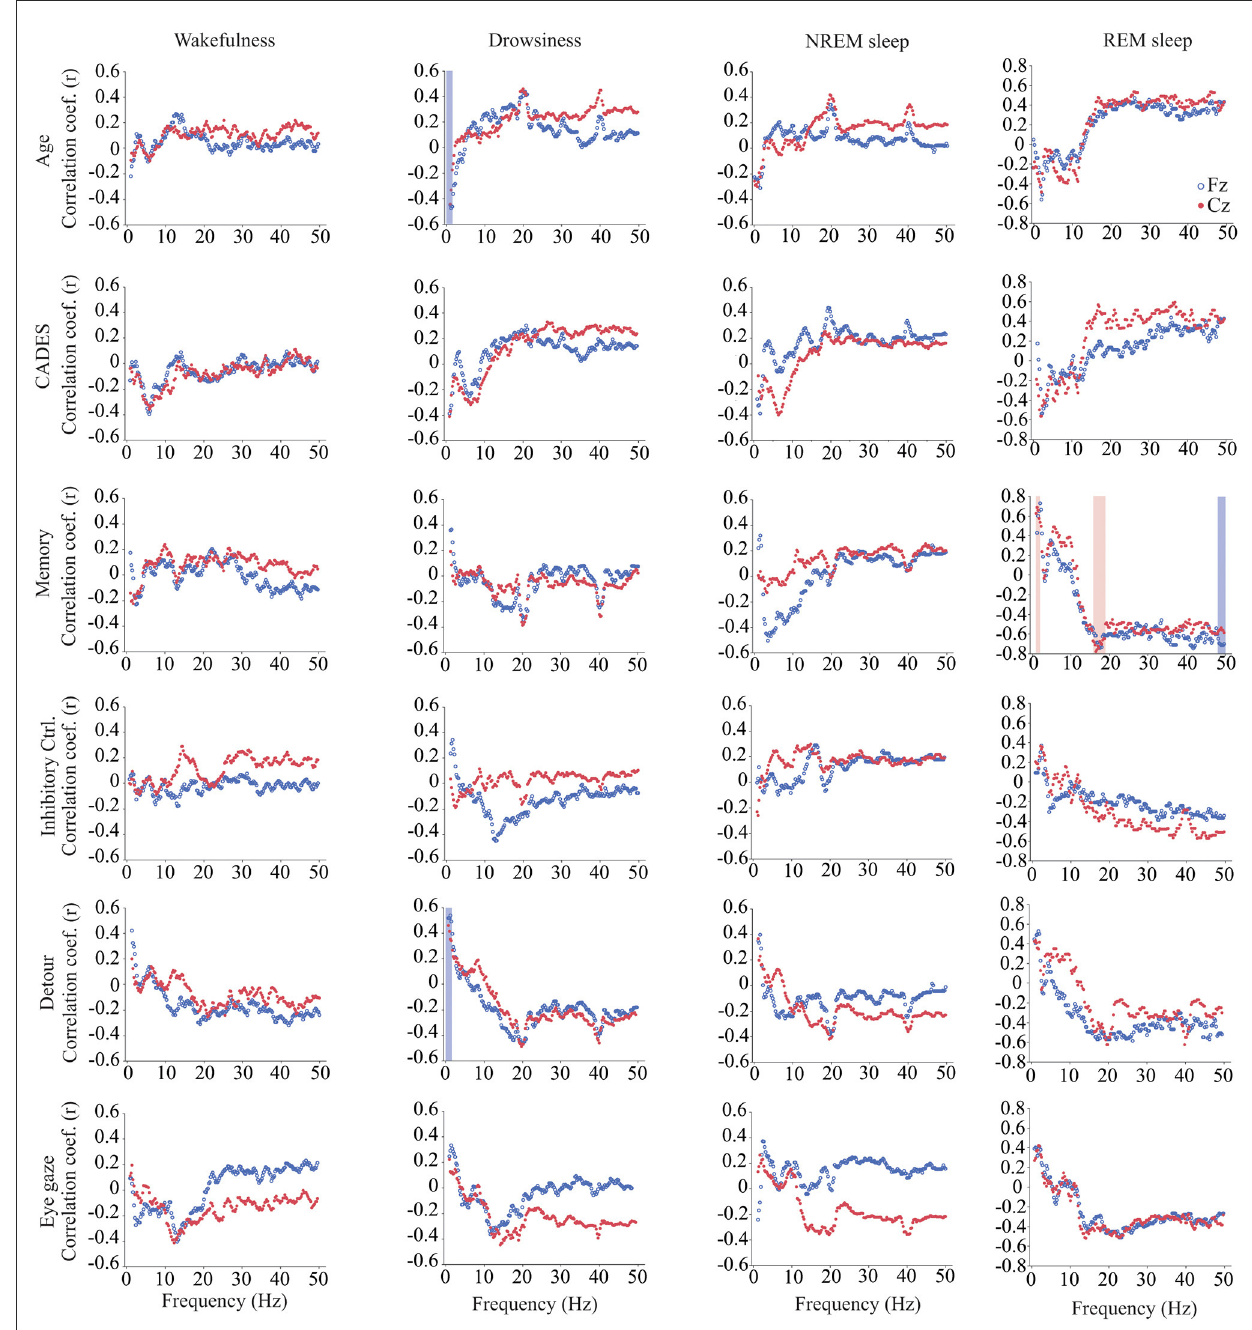
FIGURE4 Correlations between wakefulness, EEG power and age, CADES score, or performance in cognitive tests. Correlation coefficients for the EEG channels Fz (blue open circle) and Cz (red solid circle) are shown for each frequency bin. Frequencies with significant correlations are indicated with a blue (for Fz) or red (for Cz) shadow box. The analysis was performed only for the dogs that entered each specific behavioral state (wakefulness n = 28, drowsiness n = 26, and NREM sleep n = 24).